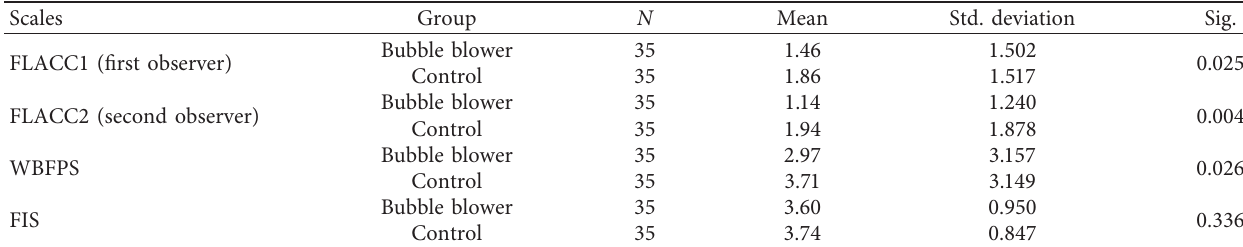
Table 2: Data of FLACC scale, WBFPS, and